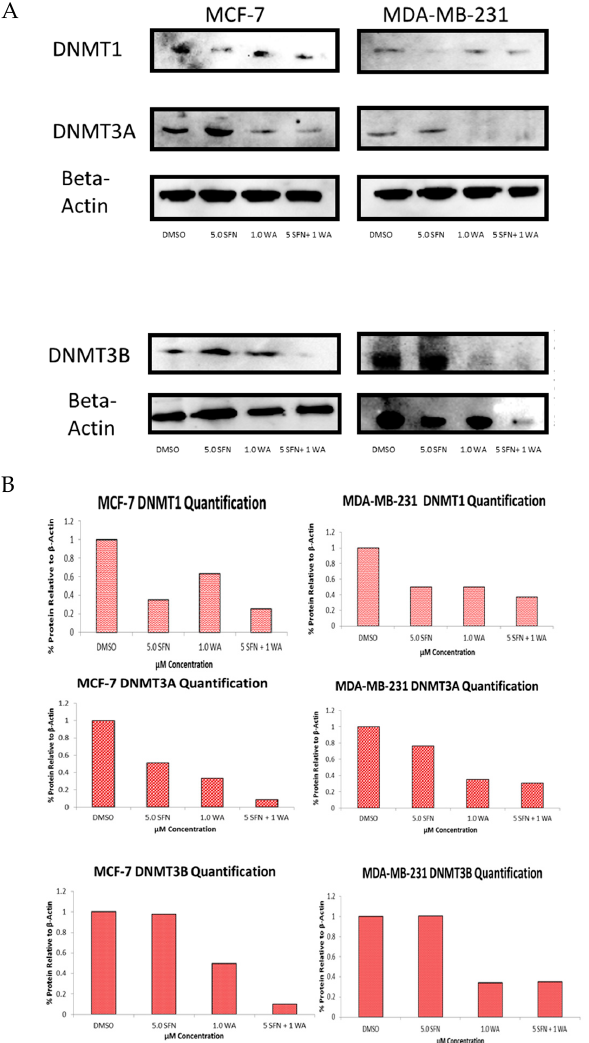
Figure 5. Combinatorial WA and SFN promote decreases in DNMT protein expression. ( A ) Representative images of the protein expression for DNMT1, DNMT3A and DNMT3B in both MCF-7 and MDA-MB-231 breast cancer cells are shown. Western blots were completed after 3-day treatments of the indicated concentrations and probed with the corresponding antibodies; ( B ) Quantification was performed using the averages of multiple blots using ImageJ software (National Institute of Health, Bethesda, MD, USA).